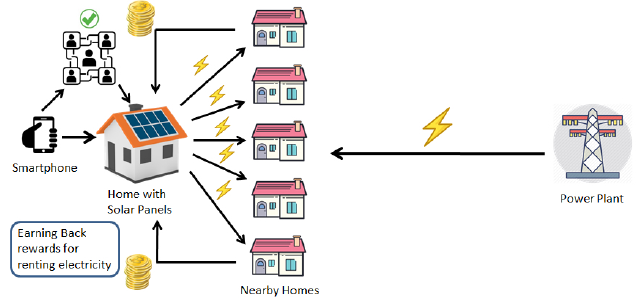
Figure 7. Sharing of energy using blockchain for energy